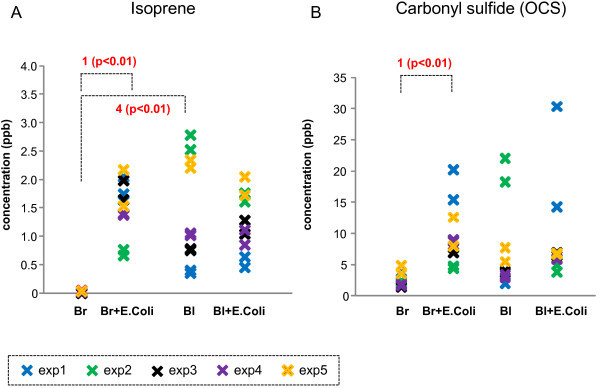
Representative patterns of VOCs in Category 2. (A) Isoprene and (B) carbonyl sulfide (OCS) emission from 4 different conditions: only (Br), E. coli in LB broth (Br + E. coli), whole blood only (B), and E. coli-inoculated whole blood (B + E. coli). 1: significantly different between Broth only and Broth + E. coli i; 2: significantly different between Blood only and Blood + E. coli i; 3: significantly different between Broth + E. coli and Blood + E. coli; 4: significantly different between Broth only and blood only.